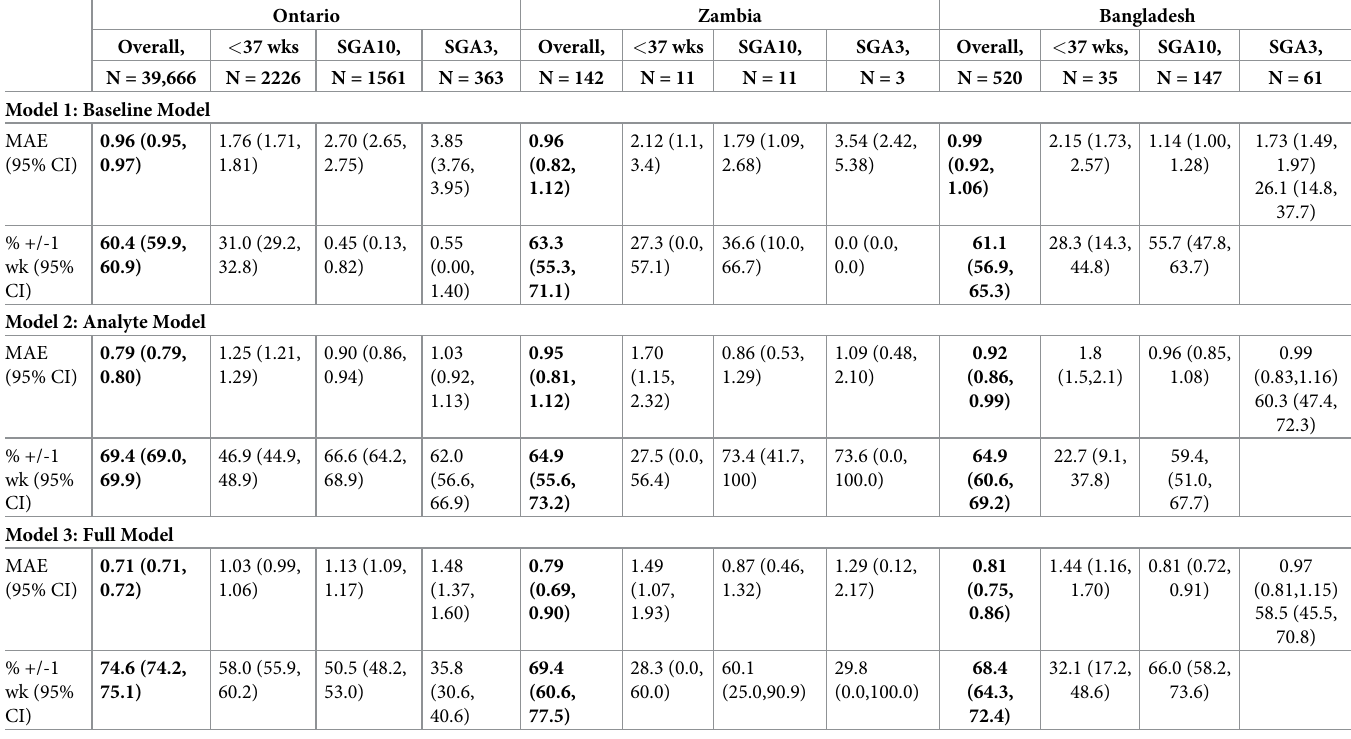
Data are presented as the mean and 2.5 th and 97.5 th bootstrap percentiles for MAE, and the percentage of model estimates within 1 week of ultrasound GA for 2000 bootstrap samples in each